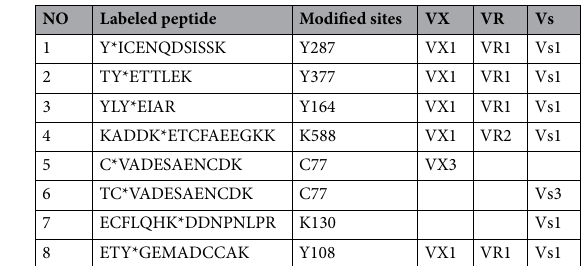
Table 8. Stably labeled peptides in human albumin after V-type OPNAs exposure.